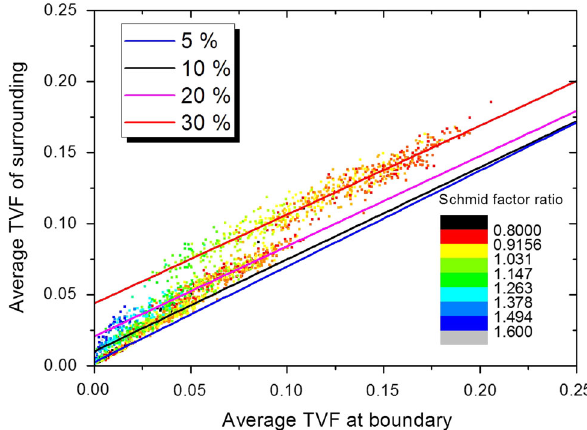
Fig. 6 Twin volume fraction of one side of the boundary to another during tensile deformation. The dotted data corresponds to that of individual grain color coded by its respective Schmid factor ratio. The straight lines colored in blue , black , magenta , and red represent averaged results after 5%, 10%, 20%, and 30% elongations,